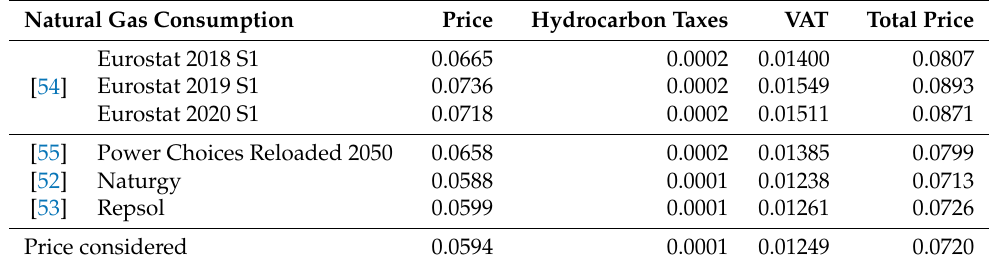
Table 2. Natural gas price (in €